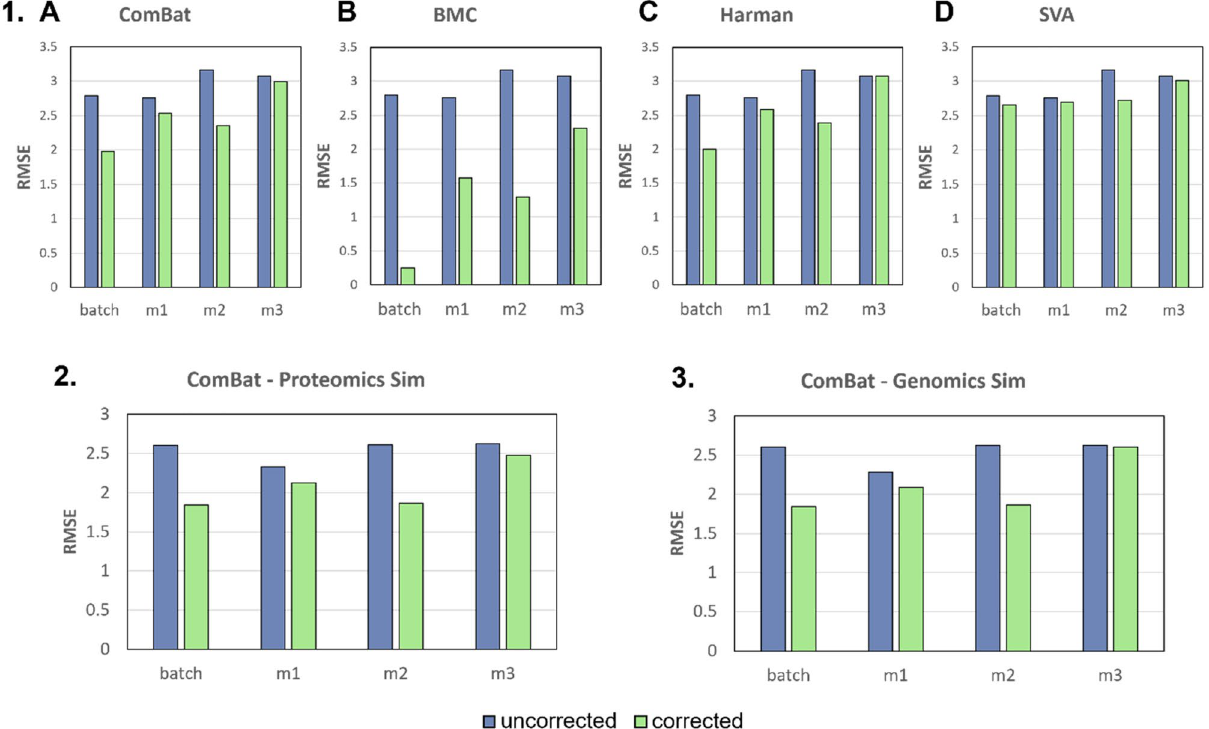
Figure 2. 4 Batch effect correction algorithms (BECAs) are used for evaluation of imputation accuracy for 1. Initial Simulation based on the root mean square error (RMSE): ( A ) ComBat ( B ) BMC ( C ) Harman ( D ) SVA. Only ComBat is used for subsequent evaluation of imputation accuracy for 2. Proteomics Simulation and 3. Genomics Simulation based on the root mean square error (RMSE). Lower values indicate higher similarity to original data